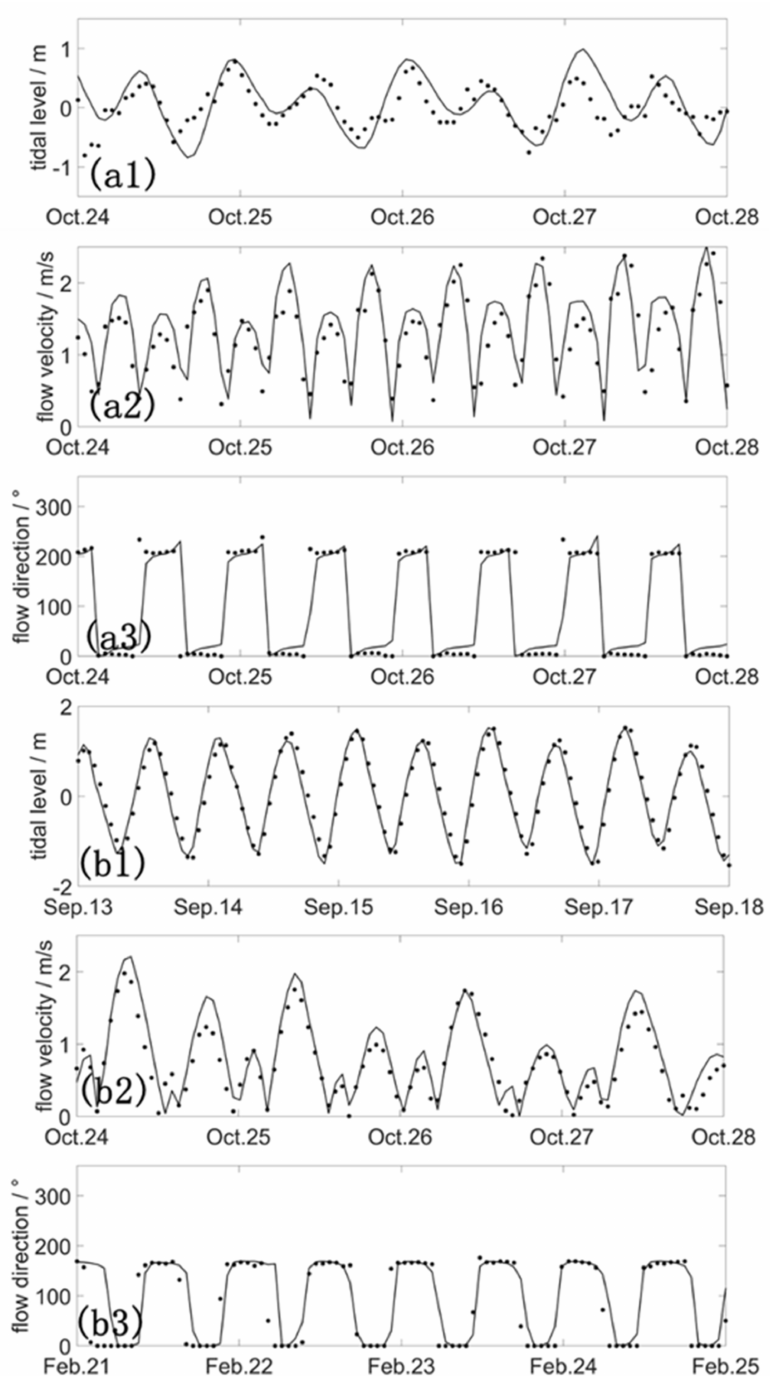
Figure 3. Tidal level comparations at ( a1 ) S1 and ( b1 ) S2. Tidal current velocities at ( a2 ) S1 and ( b2 ) S2. Tidal current directions at ( a3 ) S1 and ( b3 ) S2. Solid lines represent the model results; dotted lines represent the observational